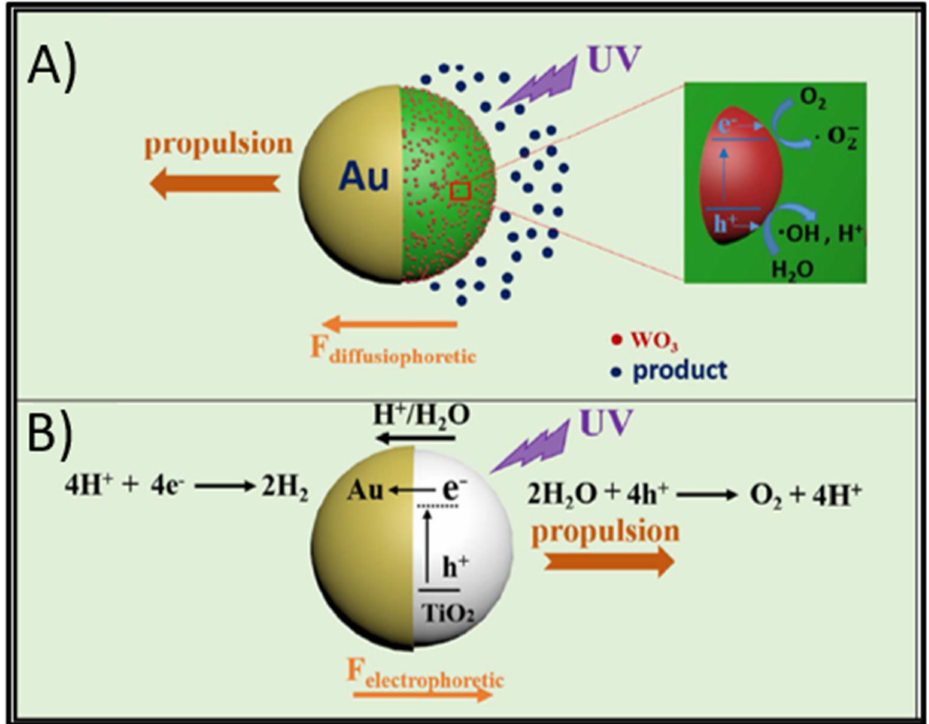
Figure 1. Propulsion mechanisms in light-driven semiconductor-based MNMs. ( A ) Diffusiophoresis. Asymmetrical decomposition of a fuel molecule establishes a concentration gradient, pushing the structure via diffusion of product species. Example: Au-WO 3 @C Janus micromotors. ( B ) Elec- trophoresis. Water redox reactions lead to an accumulation of H + ions and electrons on opposite hemispheres, inducing an electric field under which a MNM can move due to its overall surface charge (usually negative). Example: Au-TiO 2 micromotors. ( A , B ) Adapted with permission from Zhang et al. ACS Appl. Mater. Interfaces 2017, 9, 5, 4674–4683 Copyright 2017, American Chemical Society